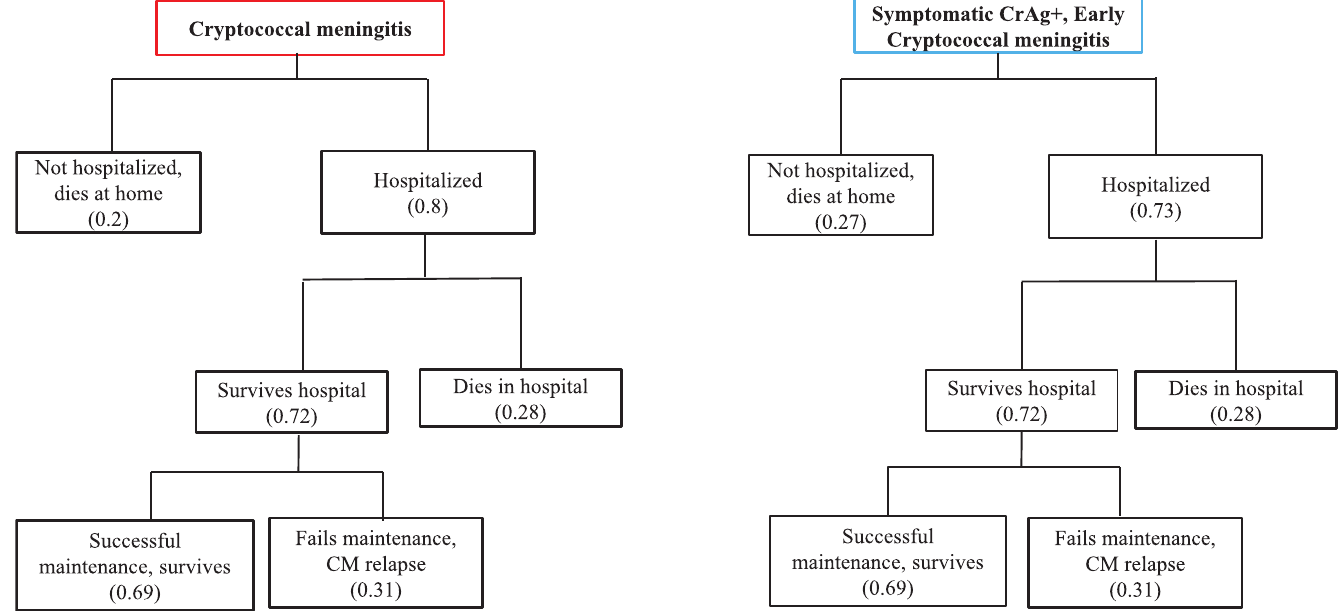
Fig 3. Left: Base case model of care of those identified with cryptococcal meningitis after not being screened, not returning to clinic, not receiving preemptive treatment, or failing preemptive treatment. Right: Base case model of care of those identified as symptomatic blood CrAg positive, with early cryptococcal meningitis. https://doi.org/10.1371/journal.pone.0210105.g003 PLOS ONE | https://doi.org/10.1371/journal.pone.0210105 January 10,